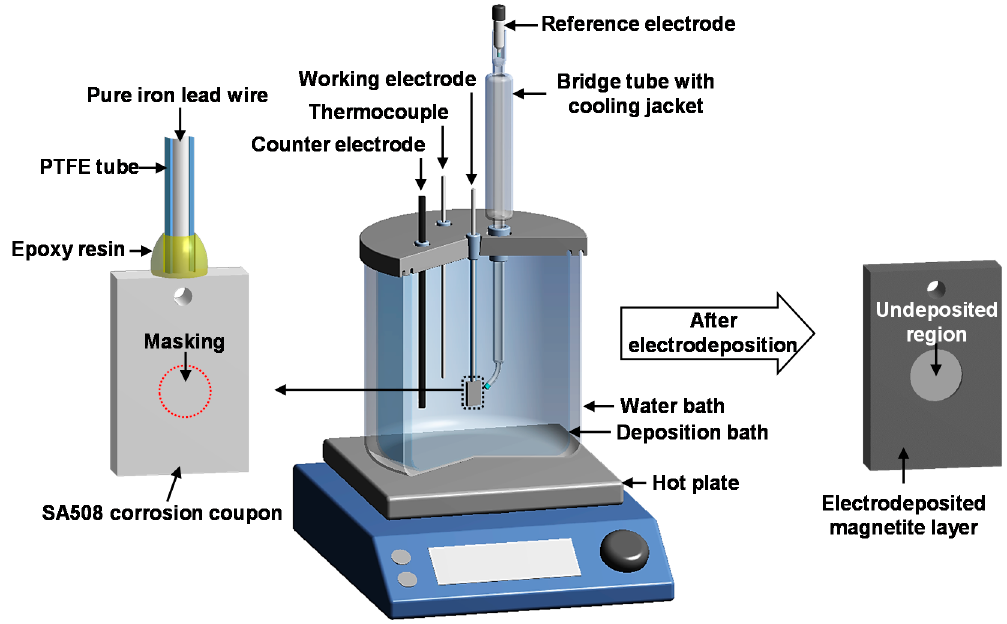
Figure 1. Schematic for the preparation of corrosion coupon coupled to magnetite.